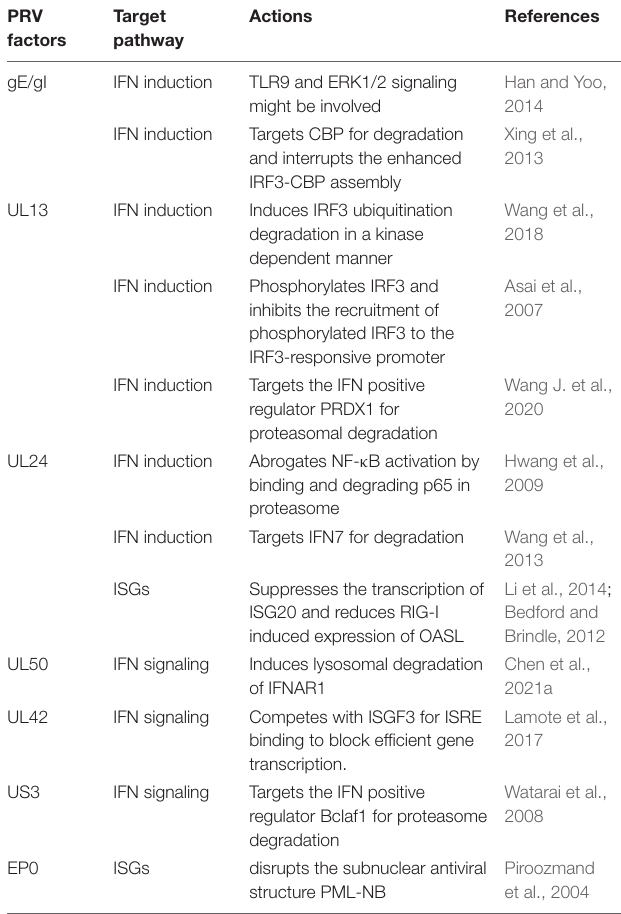
TABLE 1 | Summary of PRV factors antagonizing the IFN-I